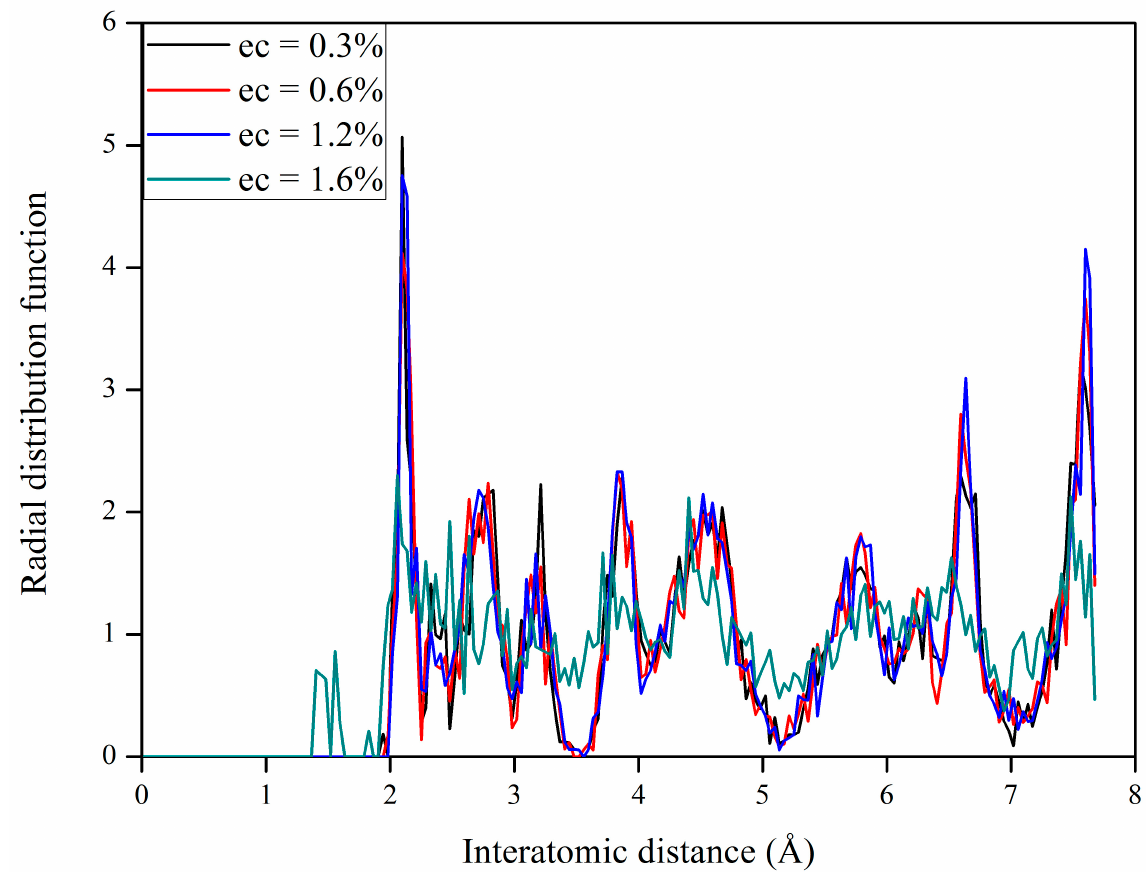
Figure 3. Radial distribution function (RDF) for La 2 Zr 2 O 7 with 0.3%, 0.6%, 1.2%, and 1.6% electron excitations.